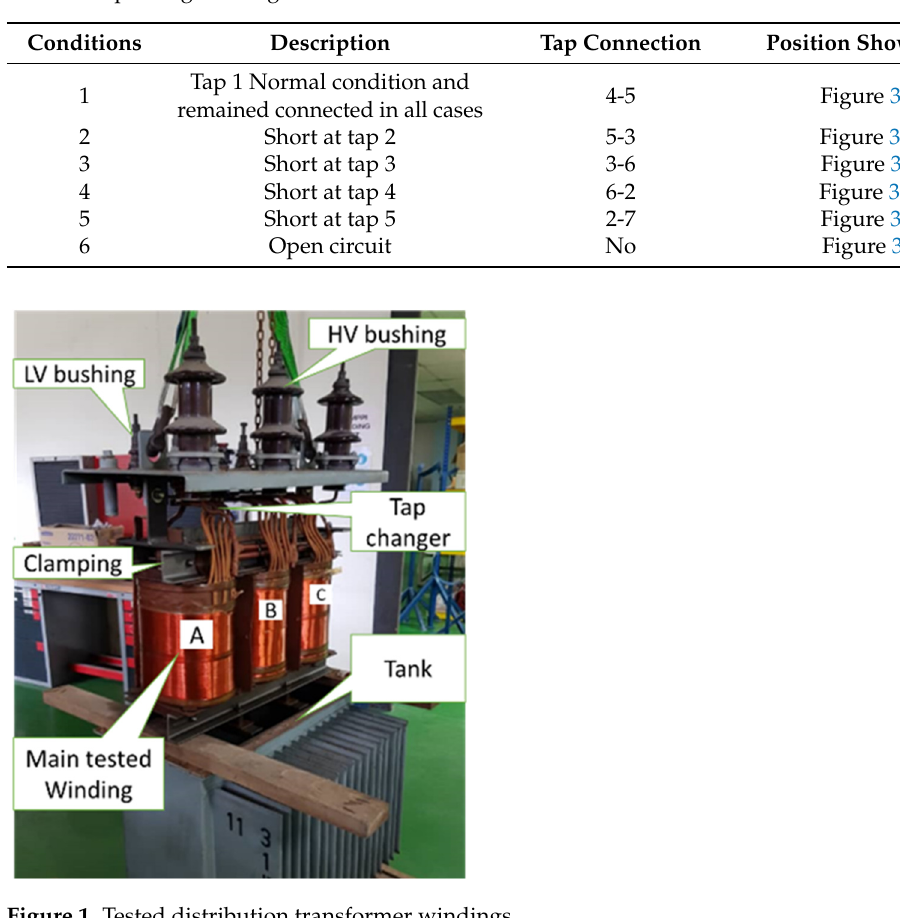
Table 5. Tap changer configuration of the tested transformer.